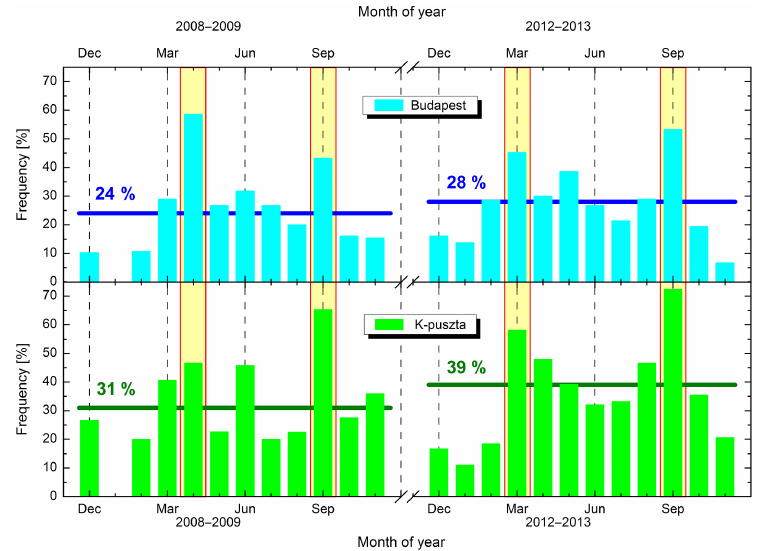
Figure 2. Distribution of monthly mean NPF frequency in Budapest and at the K-puszta station. Annual mean frequencies are indicated by horizontal lines and figures. The spring and autumn maxima are highlighted in yellow bands.